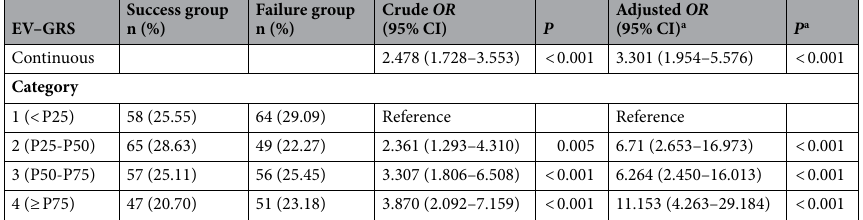
Table 2. Association between EV–GRS and the efficacy of folic acid therapy to HHcy. OR odds ratio. a Adjusted for history, hypertension, stroke, CHD and Hcy.